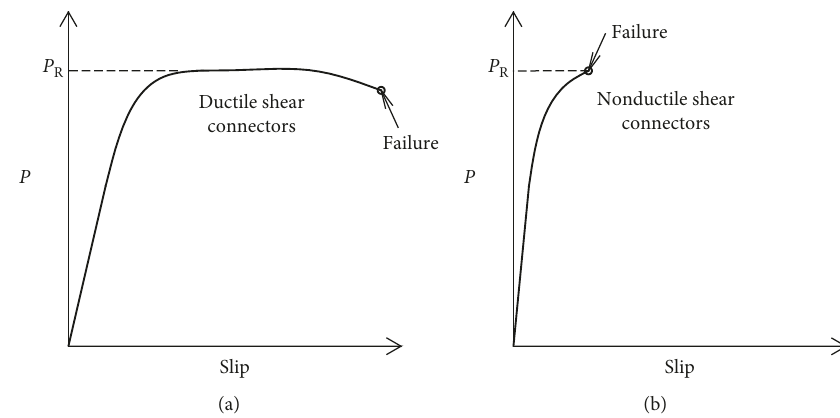
Figure 2: Typical load-slip relations for (a) ductile and (b) nonductile shear connectors.